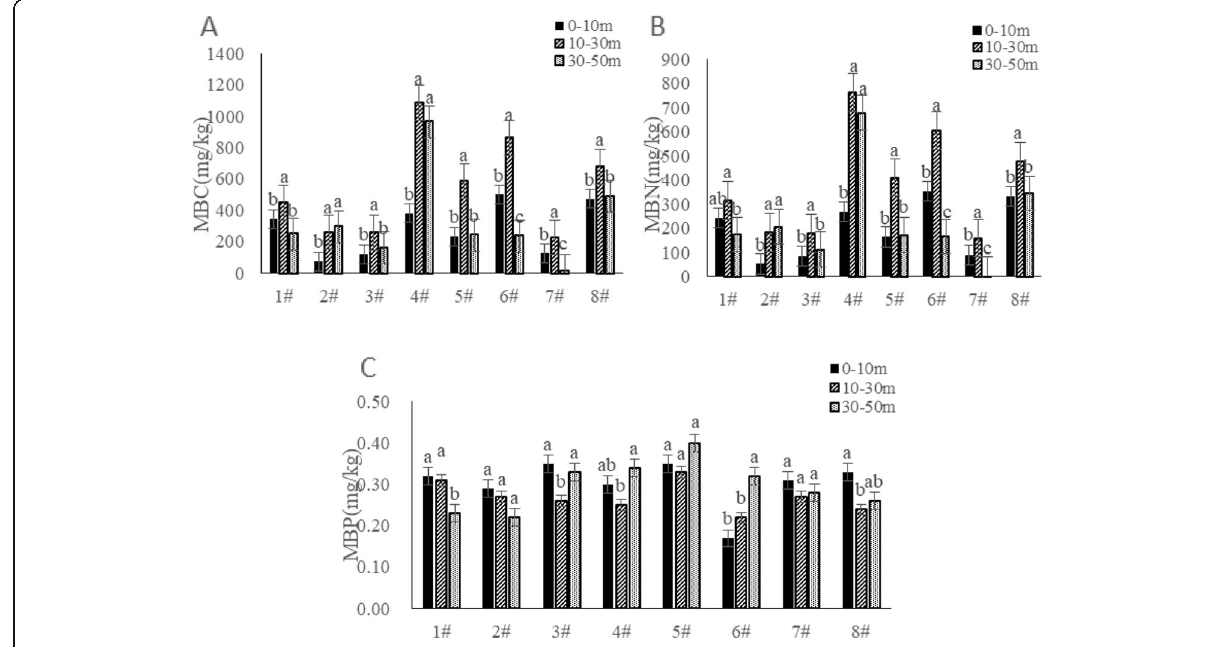
Fig. 3 Distribution characteristics of soil microbial biomass in different regions of oil well